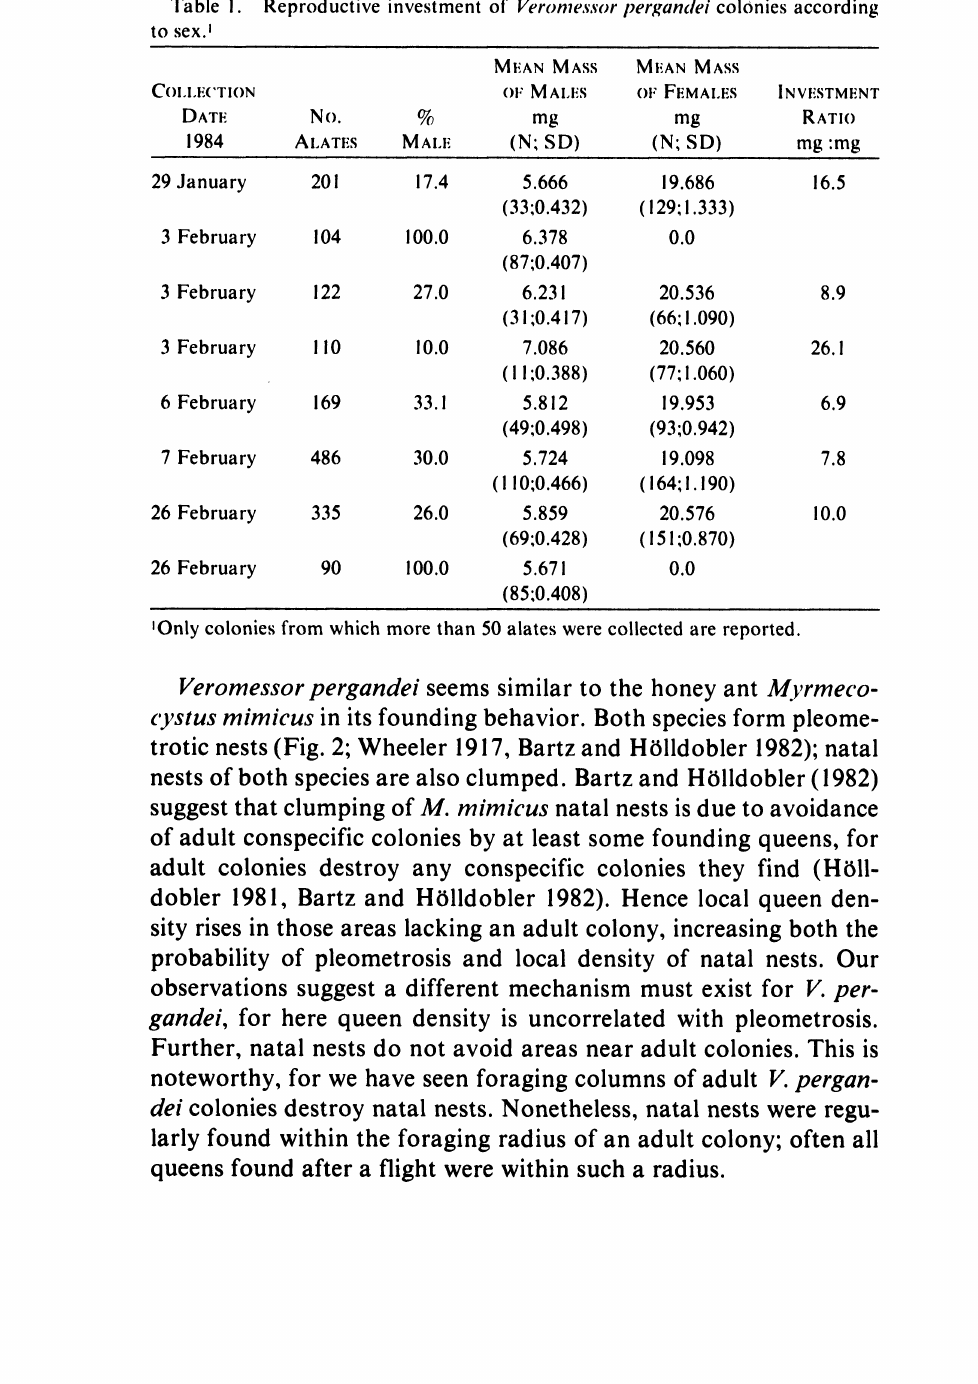
Table !. Reproductive investment of Veromessor pergandei colonies according to